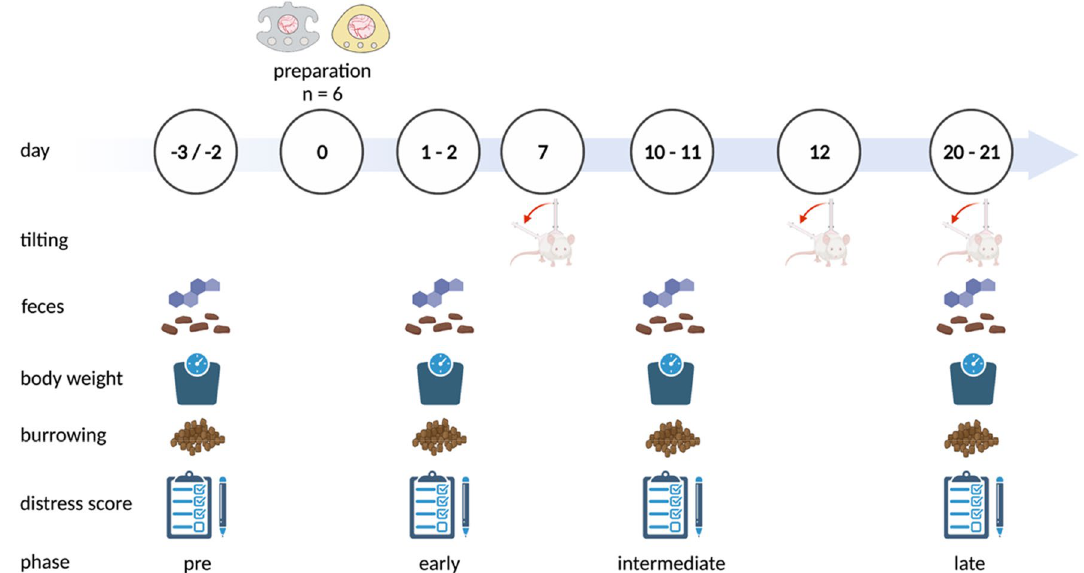
scoring were performed in a preoperative, early, intermediate, and late postoperative phase. Figure created with